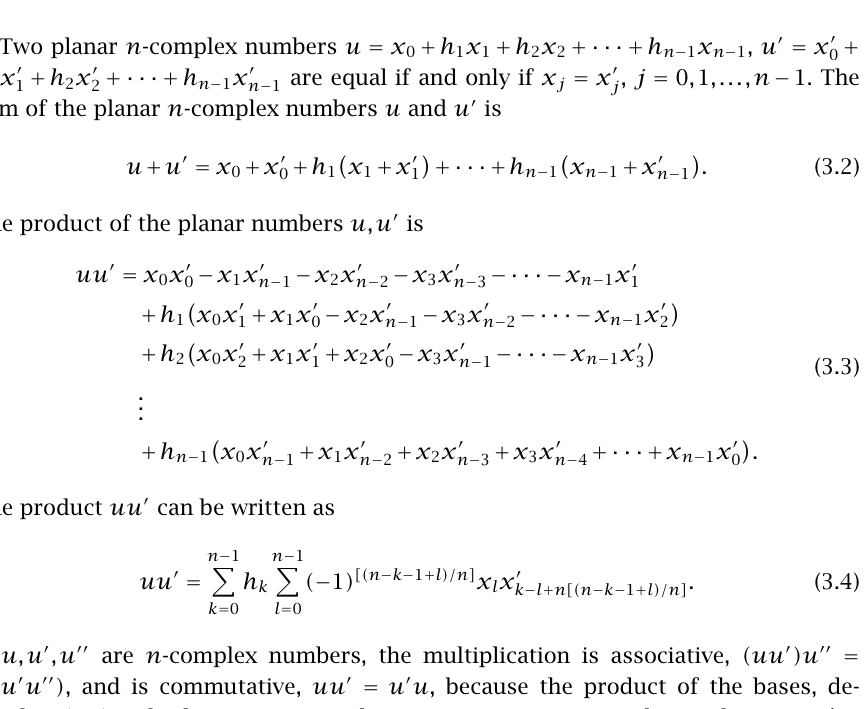
Figure 3.1 . Representation of the planar n -complex bases 1 ,h 1 ,...,h n − 1 by points on a circle at the angles α k = πk/n